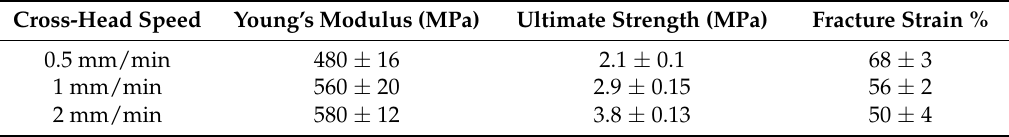
Table 1. Stress–strain data for porous polyethylene at different cross-head speeds.